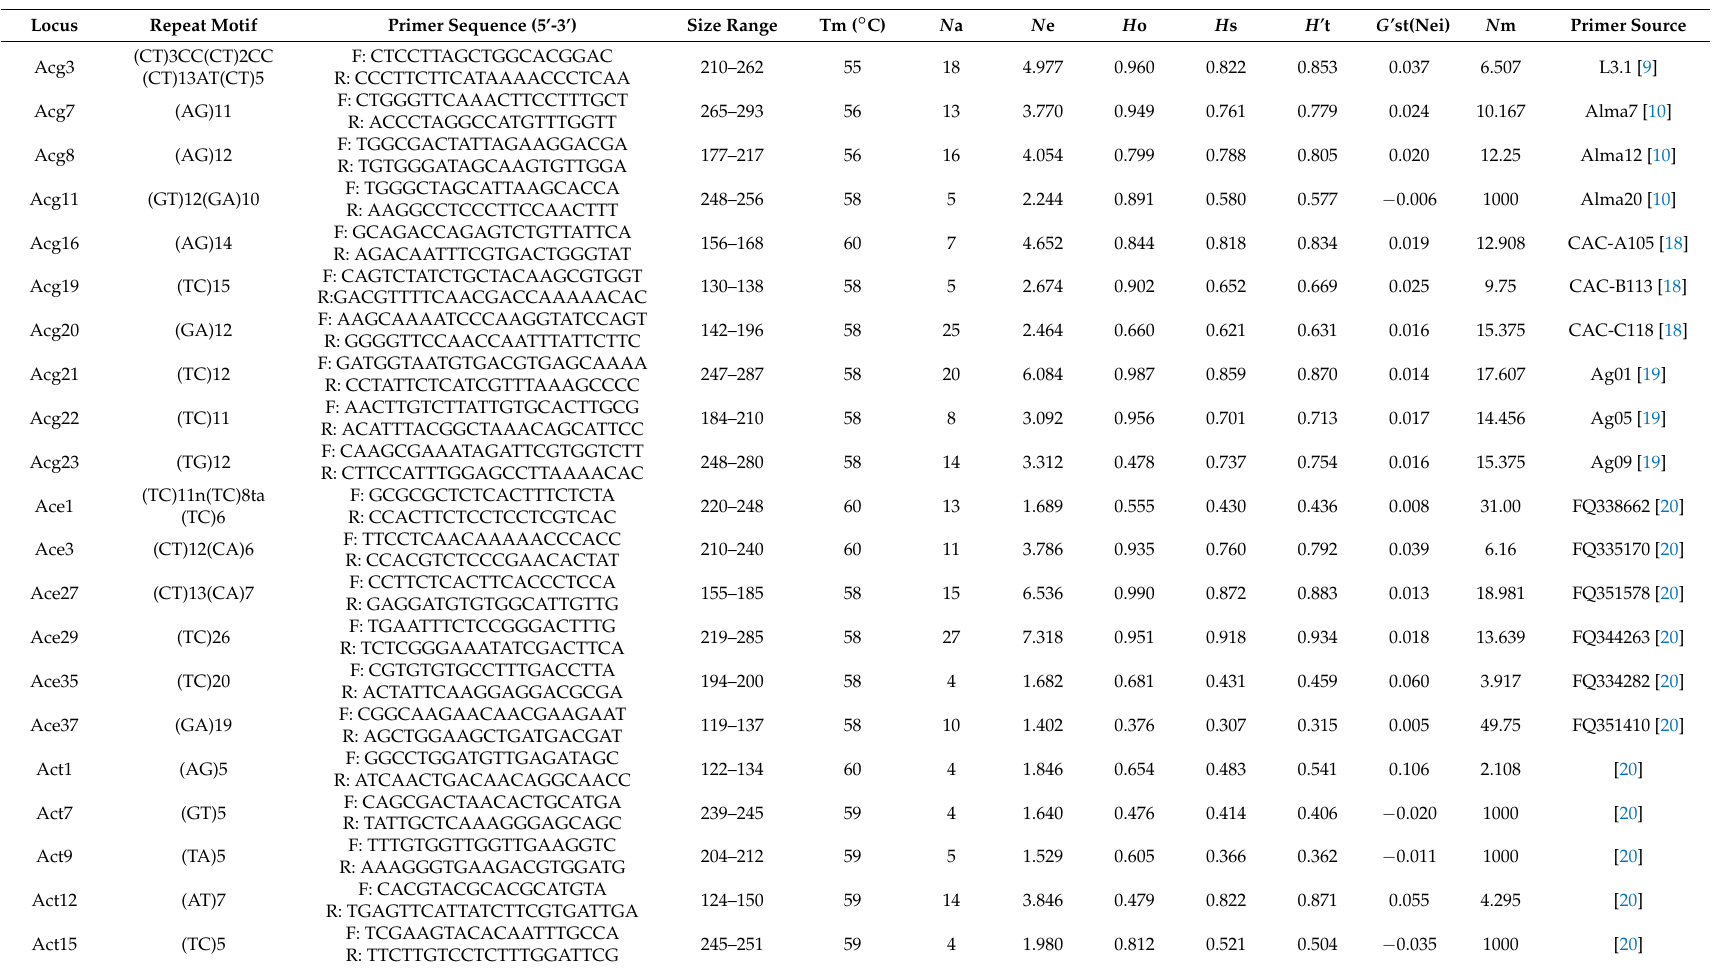
Table 2. Characterization of 25 simple sequence repeat loci in A. cremastogyne based on 175 trees representing 14 populations in Sichuan Province.